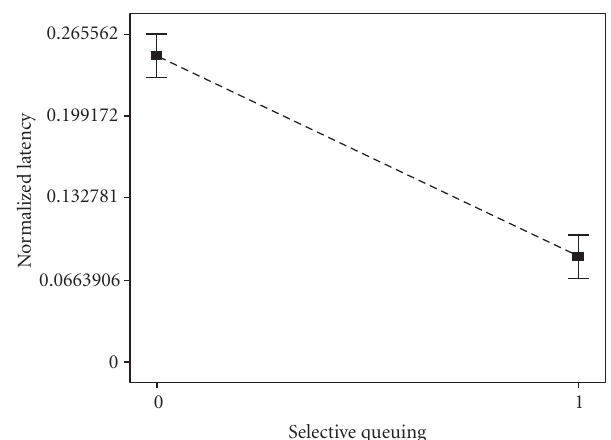
Figure 15: Analysis of selective queuing’s impact on VoIP latency.